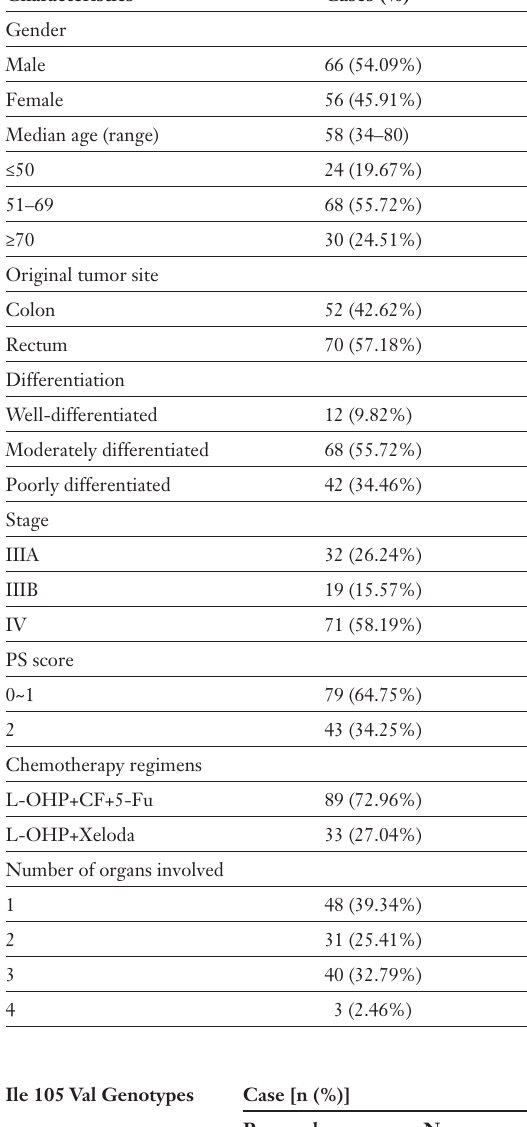
Characteristics of 122 colorectal cancer patients.